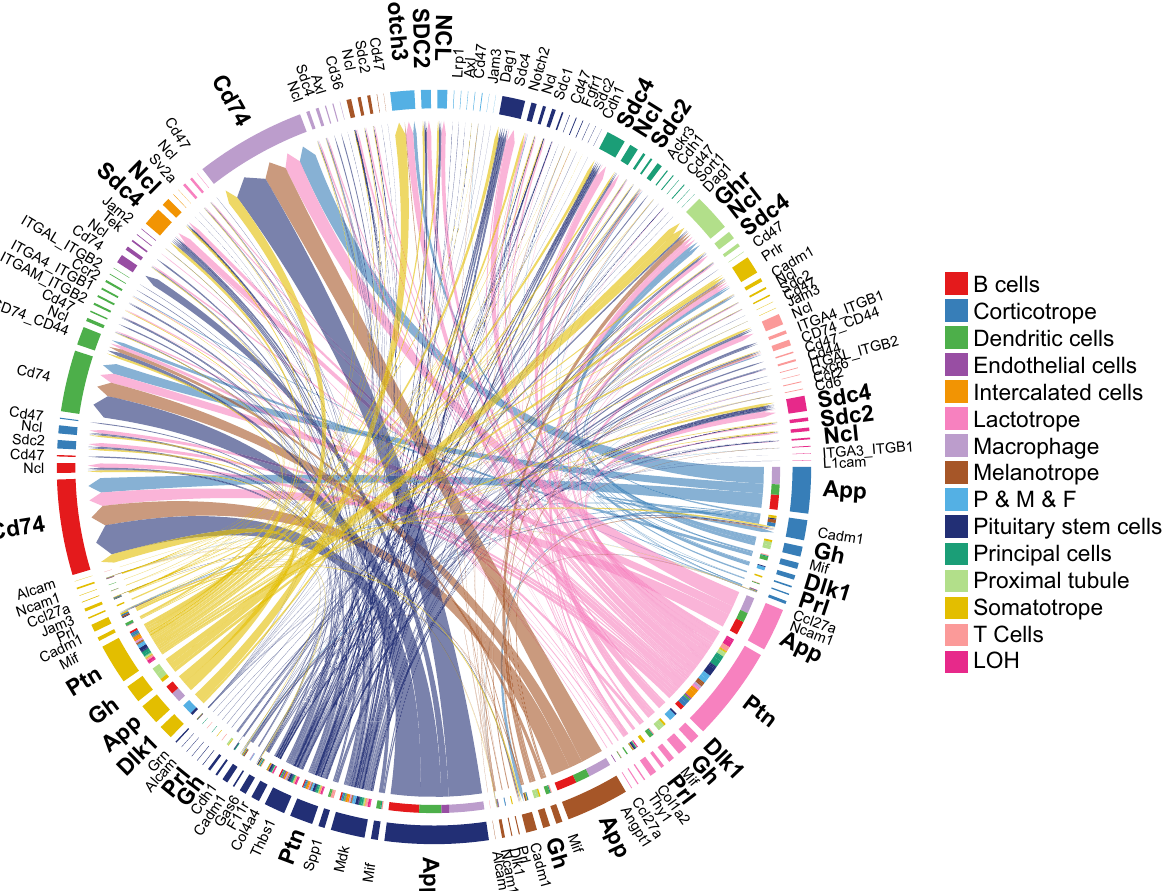
Figure 3. Cord plot of ligand–receptor pairs among the pituitary cell types. Ligand–receptor pairs in somatotropes, lactotropes, melanotropes, corticotropes and pituitary stem cells are shown, and highly active ligand–receptor pairs are